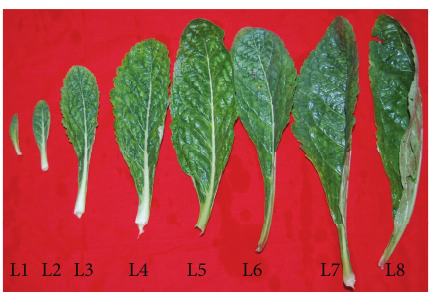
Figure 3: Leaf samples of R. glutinosa used in the study. L1–L8 represented leaves located on the top position of the stem and